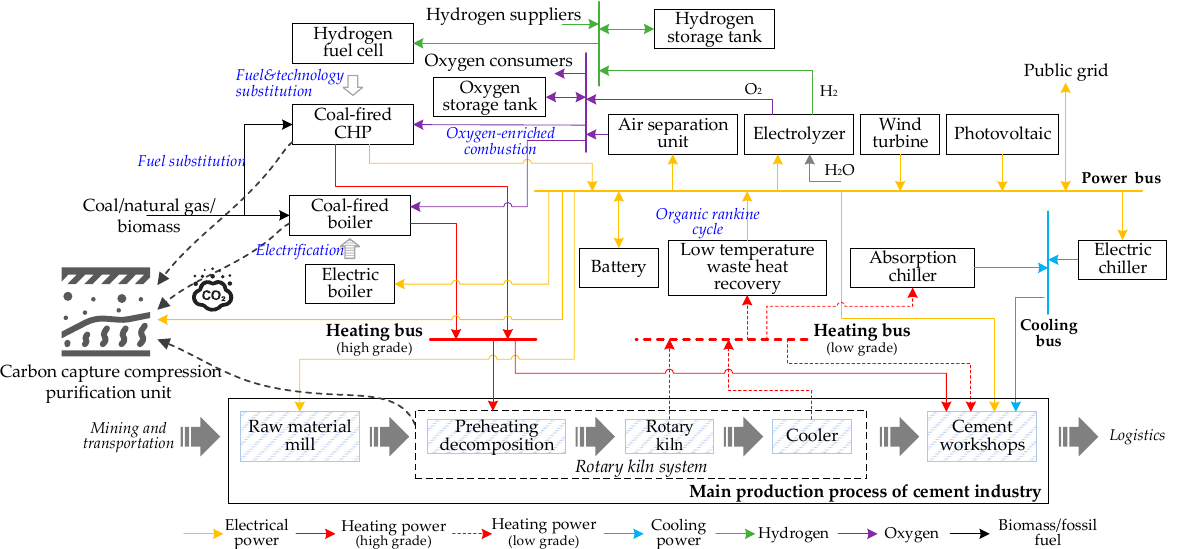
Figure 1. Structure of Cement Industry Integrated Energy System (Cement-IIES).